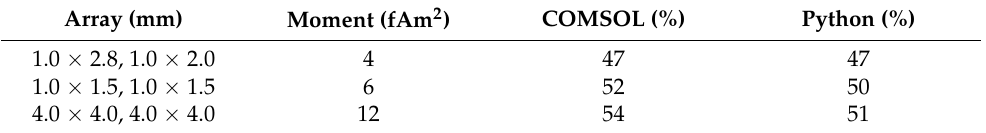
Table A1. Capture efficiencies estimated by the COMSOL finite element method compared to analytical calculations (Python). Magnetic moment of the cells was chosen such that capture was around 50%, where the designs show the highest sensitivities to variation. The difference is less than 3%.